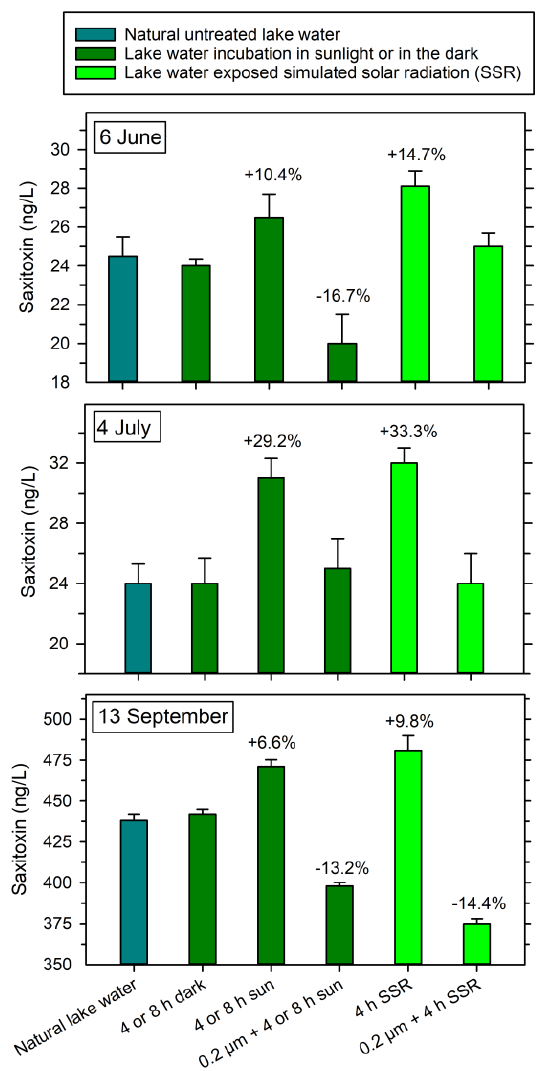
Figure 4. Changes in dissolved saxitoxin in natural Lake Arresø water and in 0.2 µ m filtered lake water incubated in SaWa ® Bags after exposure to natural sunlight, simulated solar radiation (SSR) or incubation in the dark in 2021. On 6 June, the exposure time in sunlight or dark was 4 h, while the exposure time was 8 h on 4 July and 13 September. Incubation in SSR incubator was 4 h at all three dates. The effect of treatments being significantly different from untreated natural lake water are shown as % change ( t -test, p < 0.05%). Quantification was conducted by ELISA technique. Means ± 1 STD are shown ( n =